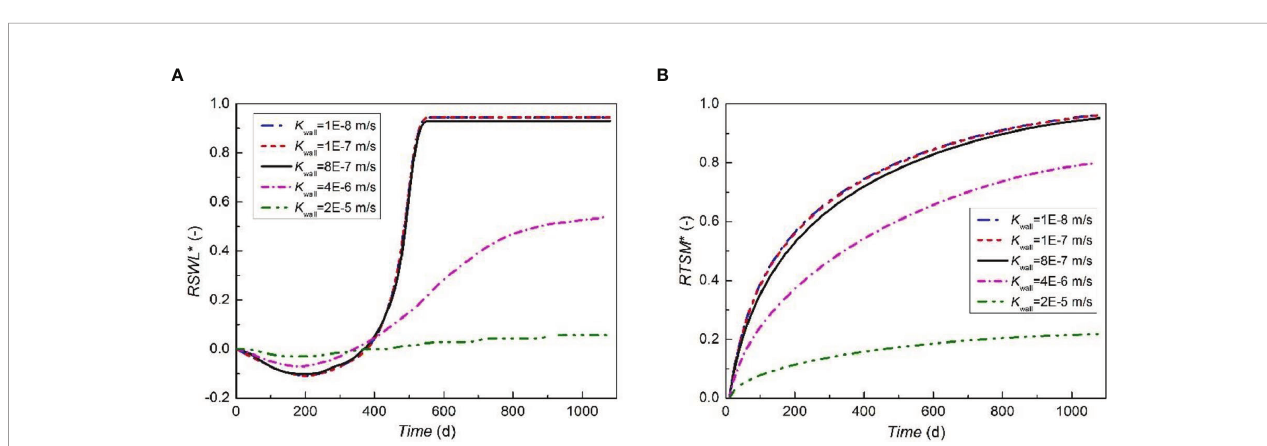
FIGURE 12 | The change of RSWL * (A) and RTSM * (B) over time after the construction of a 25 m-depth cut-off wall with hydraulic conductivity equal to 10 -8 , 10 -7 , 8×10 -7 , 4×10 -6 , 2×10 -5 m/s,